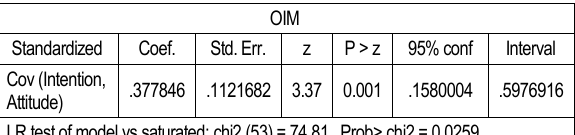
Table 4. Covariance between environmental